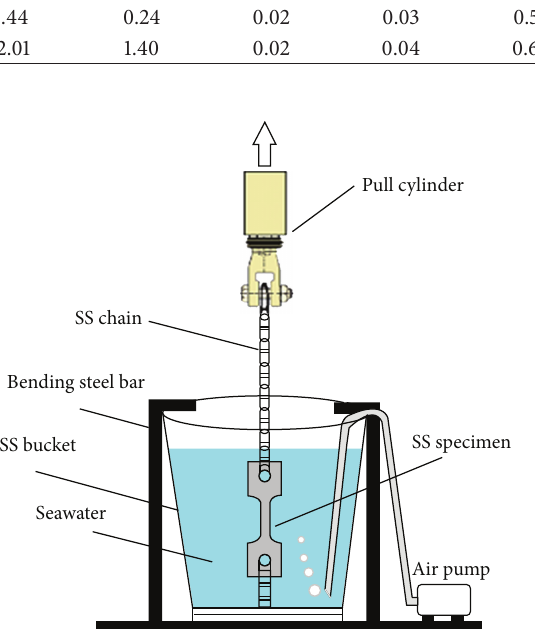
Figure 3: The figure Drawing shows the position of the specimen in the steel